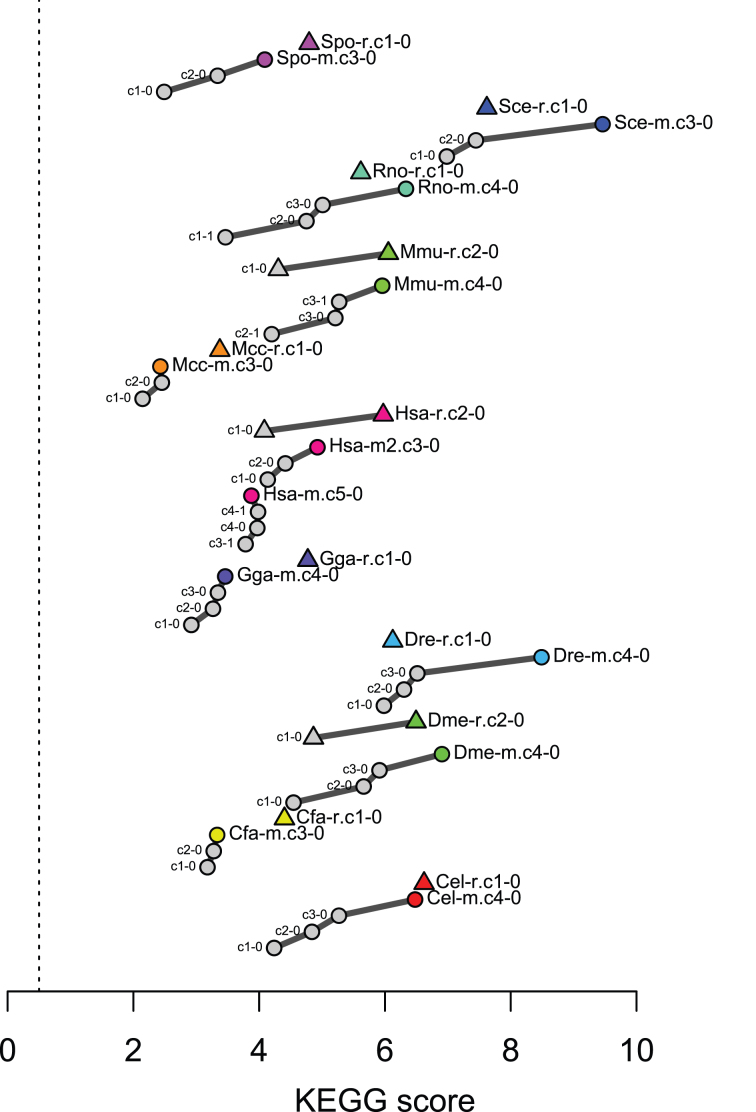
Progression of KEGG score of the coexpression data in COXPRESdb. The KEGG score shows the consistency of coexpression data with KEGG pathway annotation for each species. The following number of KEGG pathways associated with less than 50 genes were used for this quality assessment; 104 for Cel, 127 for Cfa, 97 for Dme, 86 for Dre, 98 for Gga, 117 for Hsa, 117 for Mcc, 111 for Mmu, 108 for Rno, 95 for Sce and 93 for Spo. The scores of the current coexpression version are also shown in Figure 3.